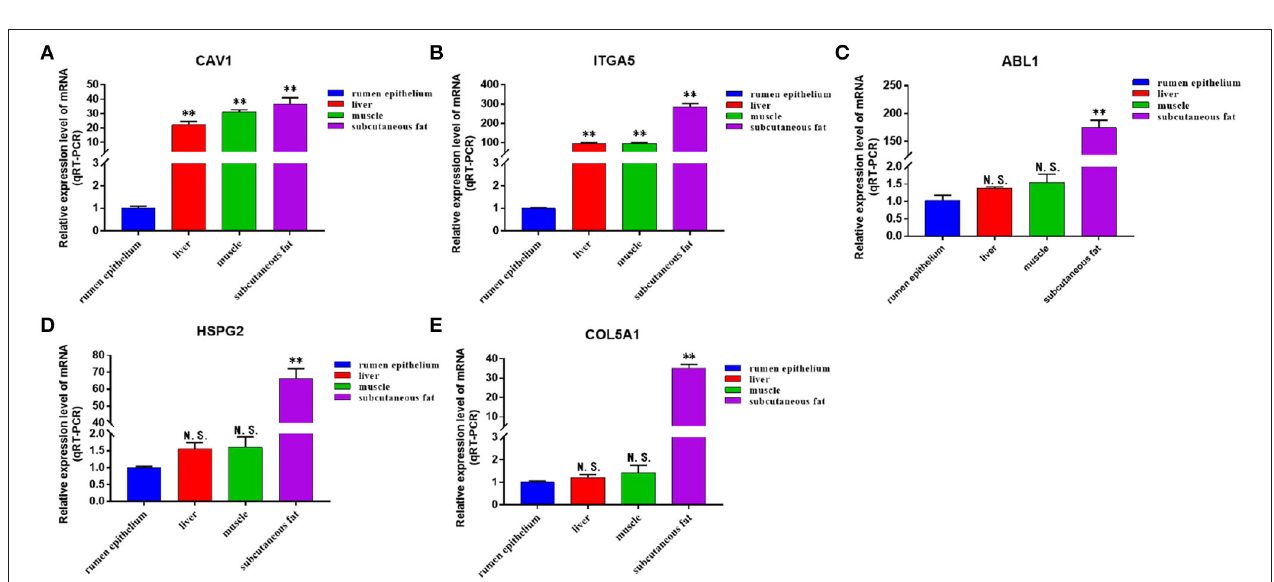
FIGURE 9 | The expression level of Hub gene in different tissue samples. (A–E) Compared with other tissues, the expression levels of (A) CAV1, (B) ITGA5, (C) ABL1, (D) HSPG2, and (E) COL5A1 in subcutaneous adipose tissue were significantly increased. Compared with the control, “*” means significant difference ( p < 0.05), “**” means extremely significant difference ( p < 0.01), and “N.S.” indicates non-significant difference.